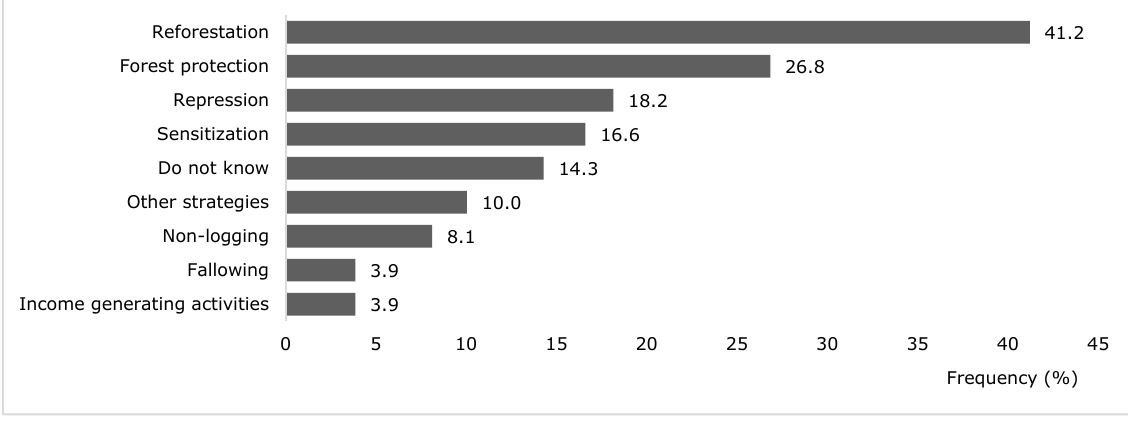
Table 6. Socioeconomic determinants affecting respondents on perceived deforestation. Explanatory Variables